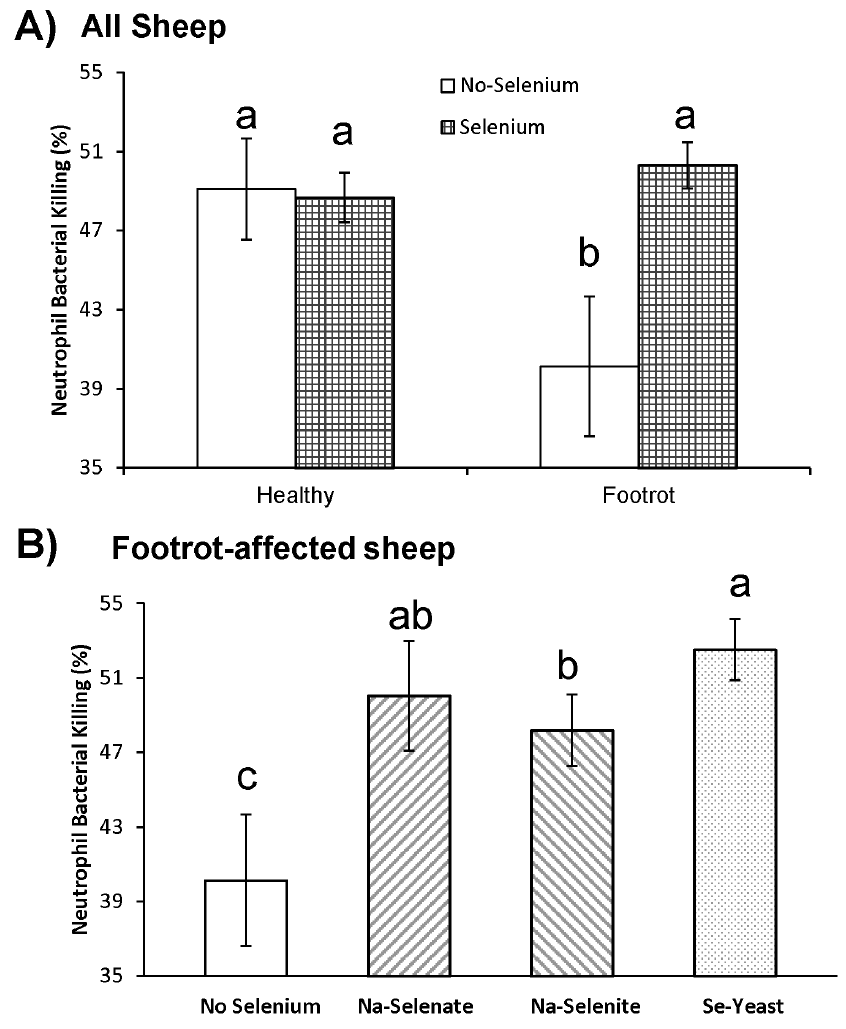
Figure 7. The effect of Se-source on ex vivo neutrophil bacterial killing in sheep. Ex vivo neutrophil bacterial killing was assessed after 60 wk of Se supplementation in healthy and footrot (FR)-affected ewes receiving no Se treatment, Na-selenate, Na-selenite, and Se-Yeast for 62 wk . A ) Weekly oral Se drenching improved neutrophil bacterial killing in FR-affected ewes to percentages that were similar to healthy supplemented or healthy non-supplemented ewes. B ) In FR-affected ewes, Na-selenate, Na-selenite, or Se-yeast improved neutrophil bacterial killing compared with no Se supplementation. The effect tended to be greater in ewes receiving Se-yeast compared with Na-selenite. The three dosages of Na-selenite or Se-yeast were combined because they did not differ. Different superscripts indicate group differences at P #